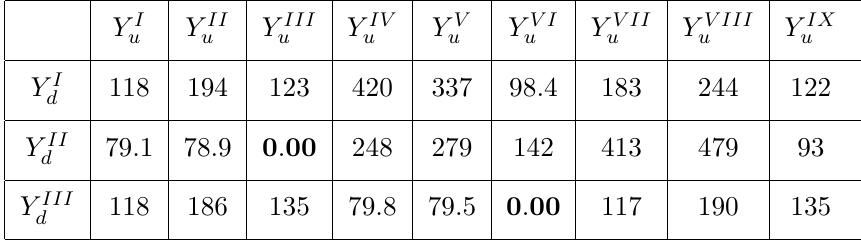
Table 4 . (cid:31) 2 for all 27 combinations of Y u ; Y d min,Q